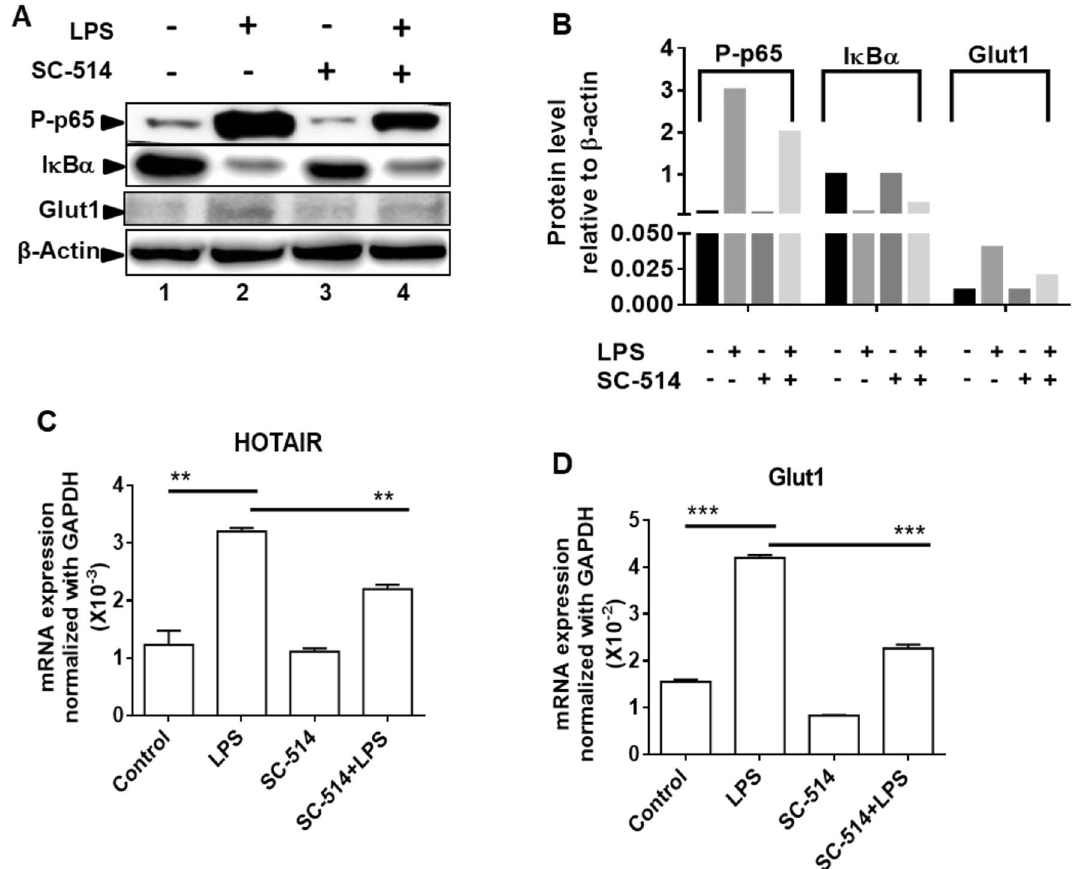
Figure 2. Inhibition of NF-κB downregulates LPS-induced Glut1 expression in macrophages. ( A , B ) RAW264.7 cells were initially treated with IKKβ-inhibitor SC-514 (for 1 h) and then treated with LPS for additional 1 h (for protein analysis) and 4 h (for RNA analysis). Proteins were analyzed by western blotting using antibodies against phospho-p65 (NF-κB subunit), IκBα, Glut1, and β-actin (loading control) (panel A , quantifications in panel B ). ( C , D ) RNA was isolated from above treated and control cells. Expressions (relative to GAPDH) of HOTAIR, and Glut1 were measured by RT-qPCR. GAPDH was used as control. Data represent mean ± SD (n = 3); *p < 0.05, **p < 0.001, ***p <